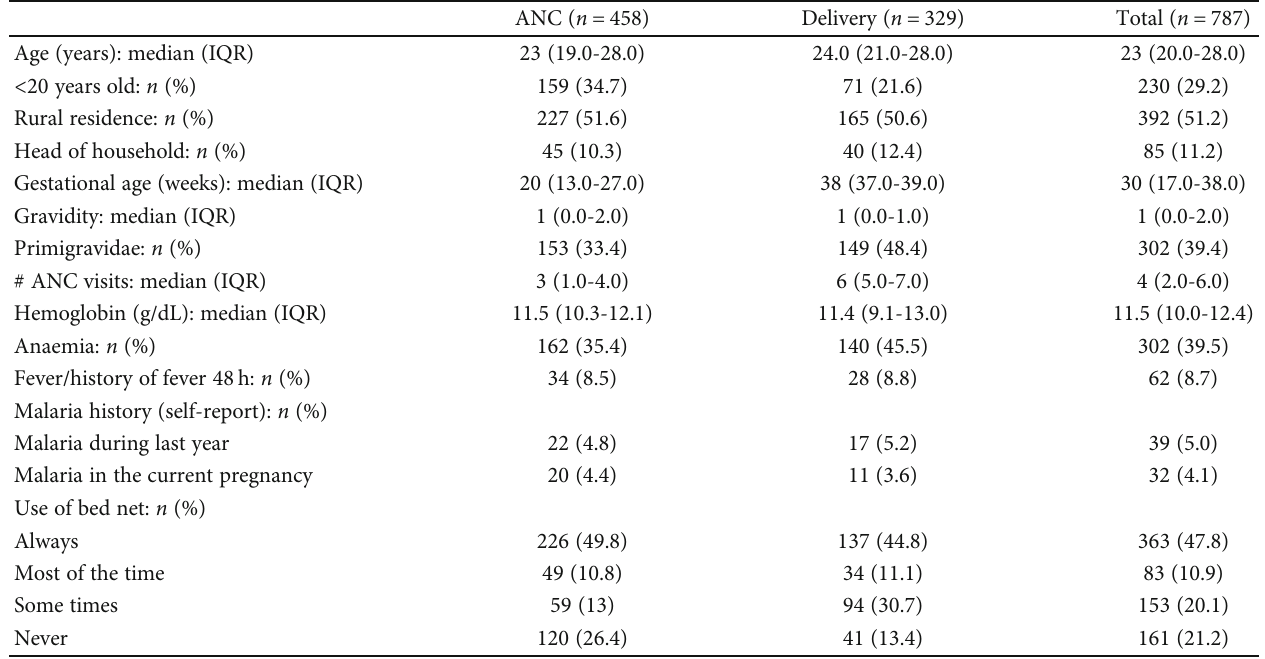
Table 1: Baseline characteristics of pregnant women enrolled.